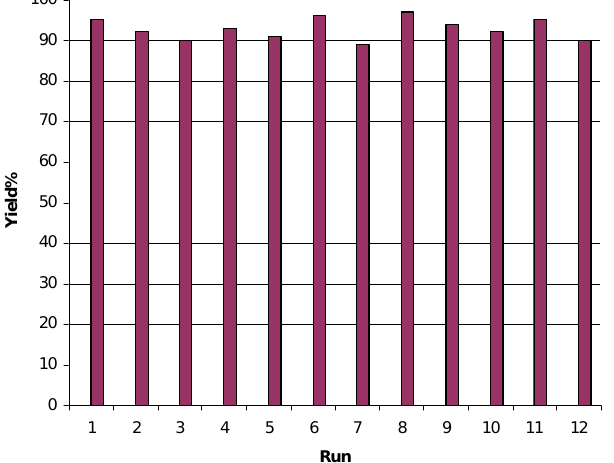
Figure 1 . Recyclability of SBSSA (0.1 g) in the condensation reaction of o - phenylenediamine (1 mmol) with 1,2-dibenzylketone (1 mmol) at room temperature. Reaction time = 5